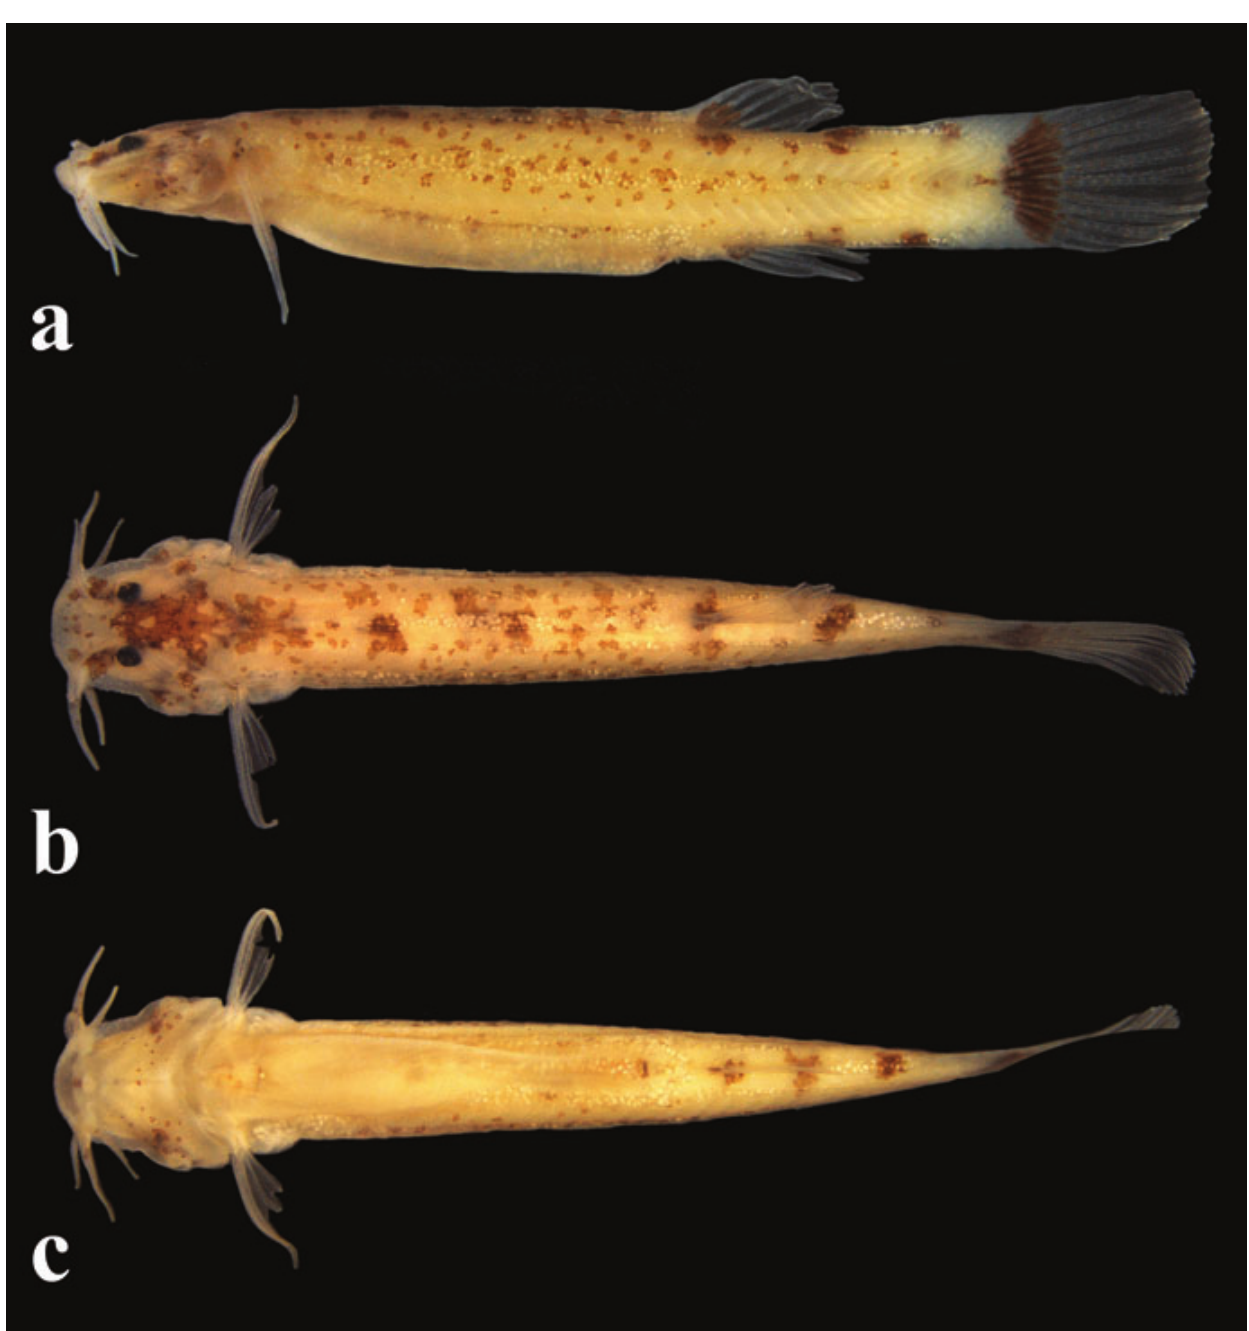
Fig. 1. Trichomycterus anhanga , holotype, INPA 25125, 10.0 mm SL. Brazil, Amazonas, igarapé Extrema, tributary of rio Aripuanã, rio Madeira drainage. a ) lateral view; b ) dorsal view; c ) ventral